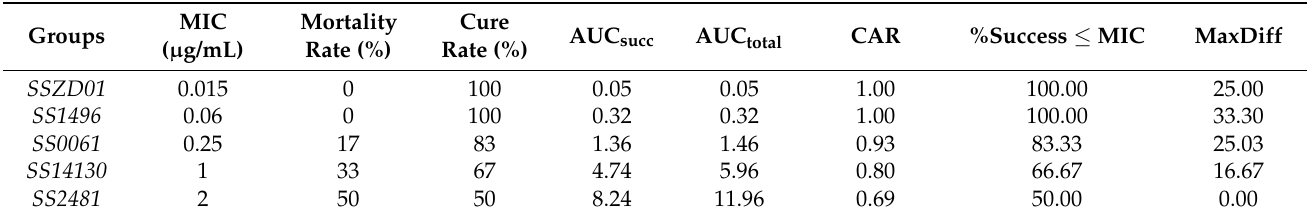
Table 5. The efficacy of cefquinome for the treatment of pig streptococcicosis caused by different MIC isolates.